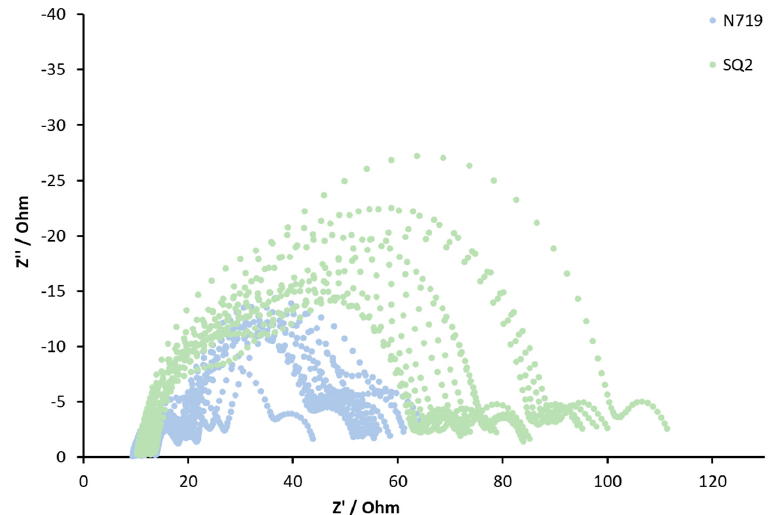
Figure 6. Nyquist plots of the DSCs with N719 (blue) and SQ2 (green) sensitizers. The plots represent the experimental data.